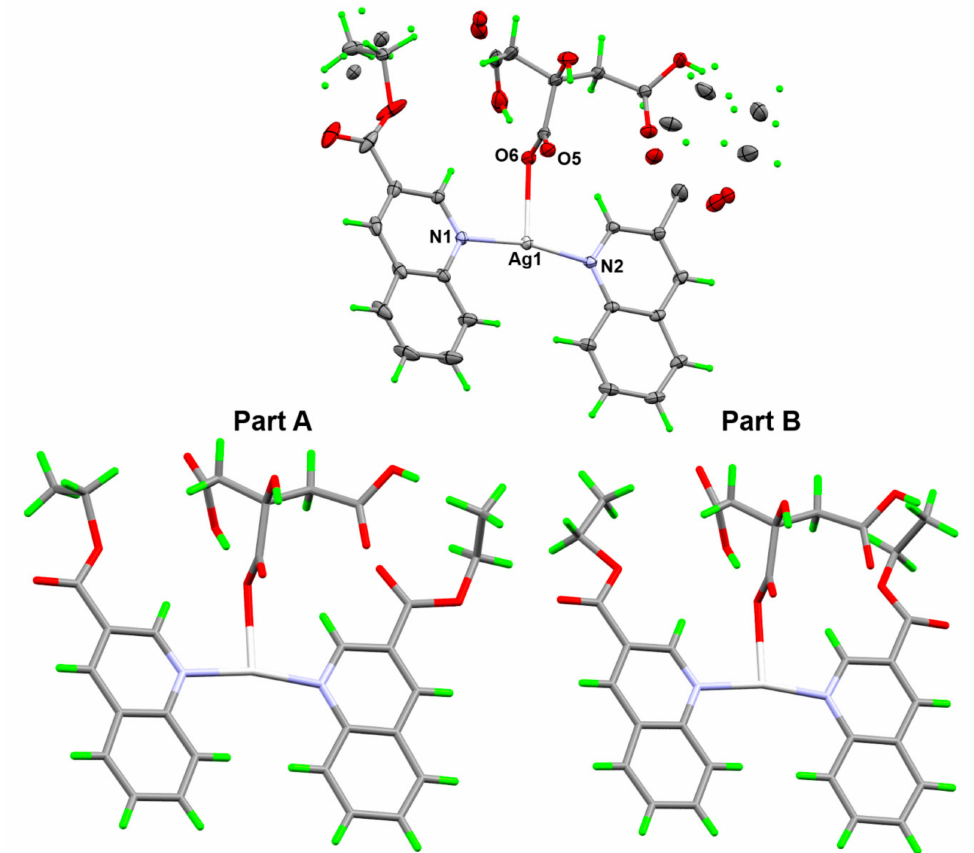
Figure 2. Crystal structure of the [Ag(Et3qu) 2 (citrate)] complex. The structure showed some disorder at the ethyl groups of the ester moieties in the coordinated Et3qu ligand